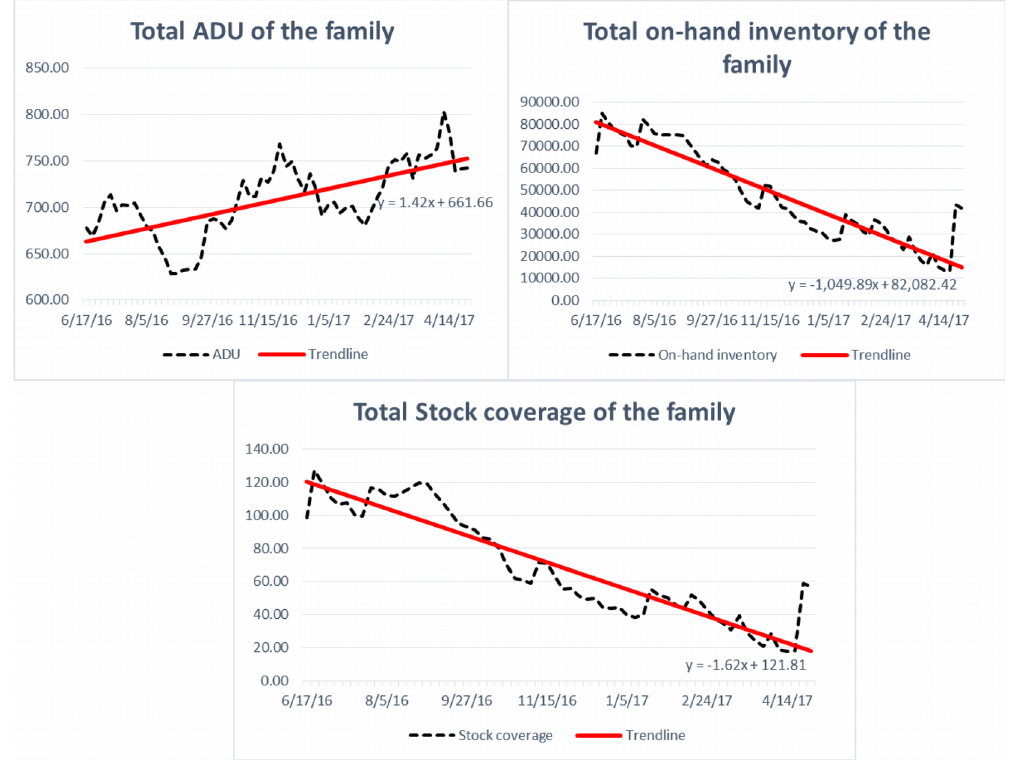
Figure 11. (a) the ADU, (b) on-hand inventory and (c) stock coverage of the analyzed family